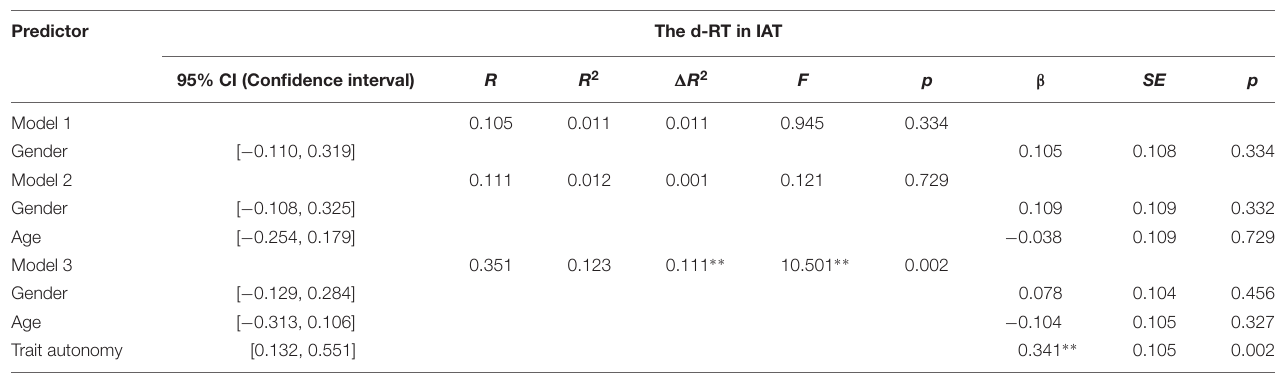
TABLE 2 | The hierarchical regression of predictors on choice effect in Study 1. Predictor The d-RT in